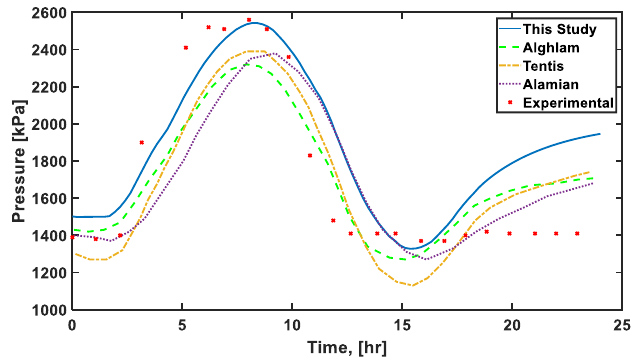
Figure 5. Pipeline outlet pressure comparison with the experimental data and other studies.